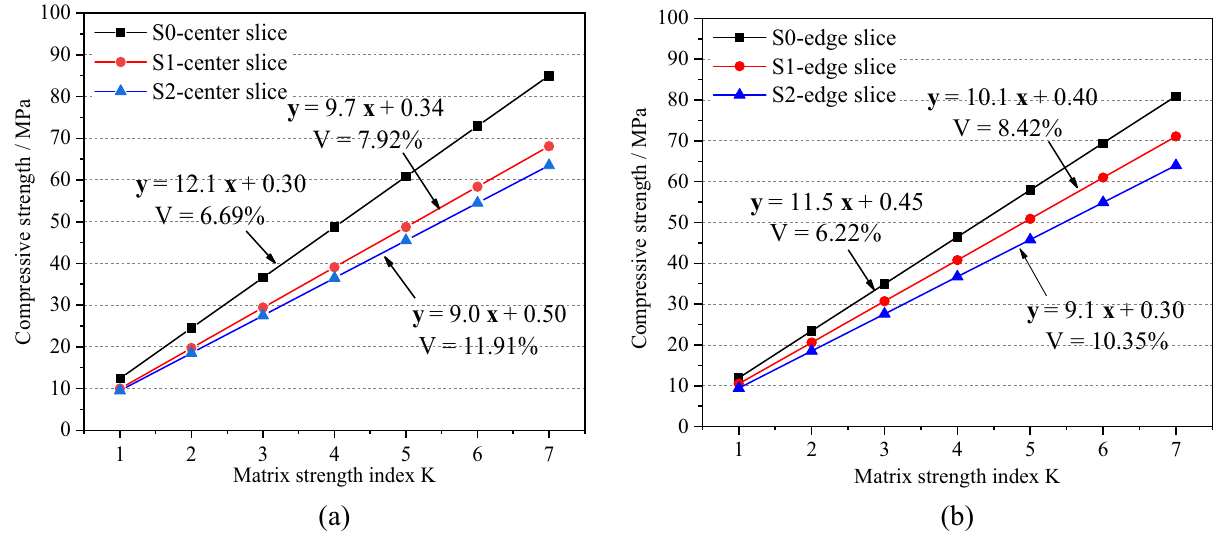
Figure 14: Relationship between K and compressive strength. ( a ) Center slice and ( b ) edge slice.